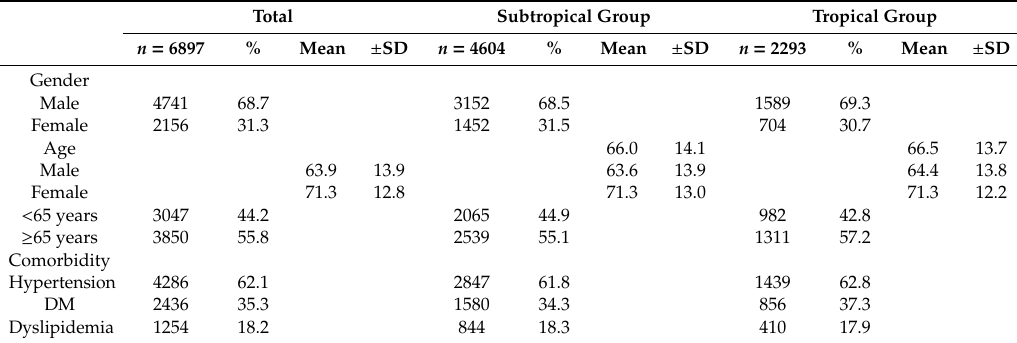
Table 2. Descriptive statistics of study